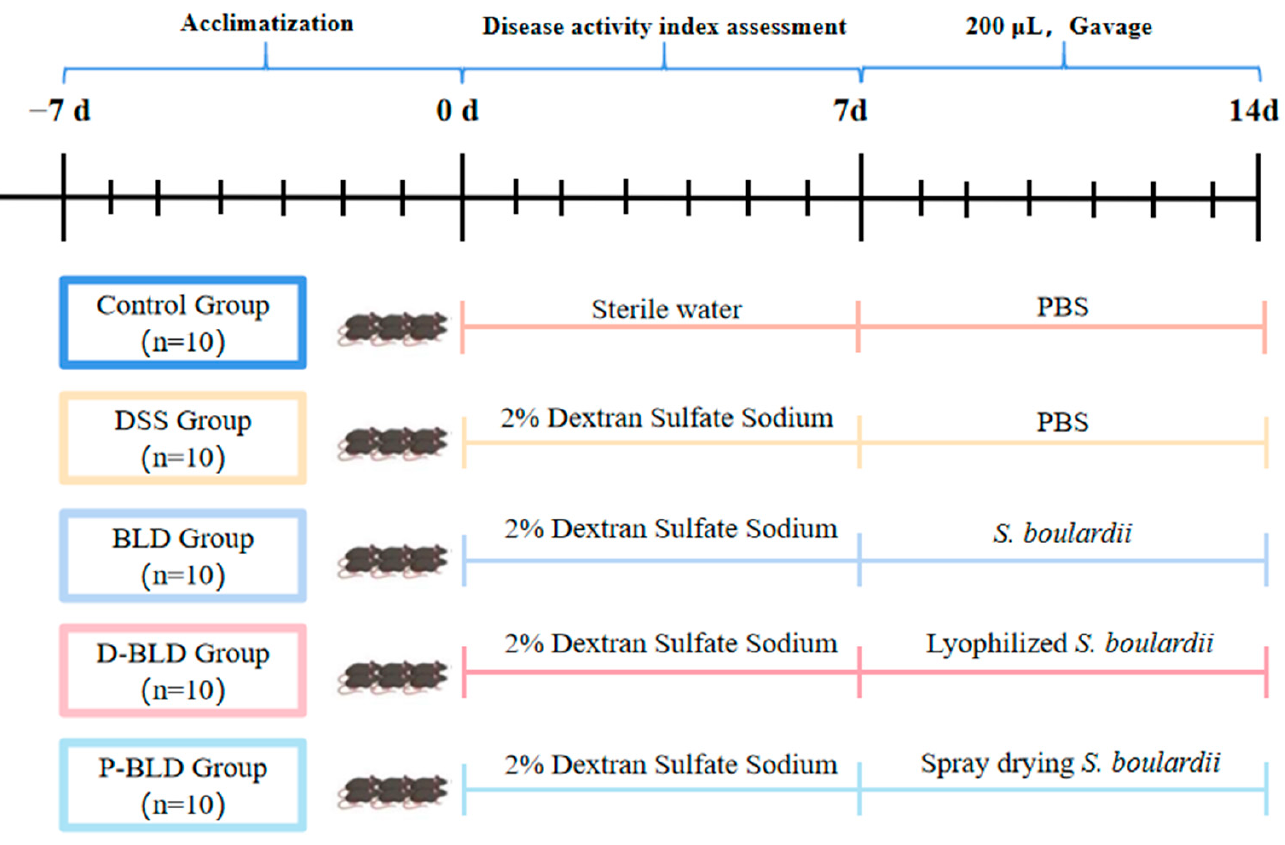
Figure 1. E xperimental design. Figure 1. Experimental